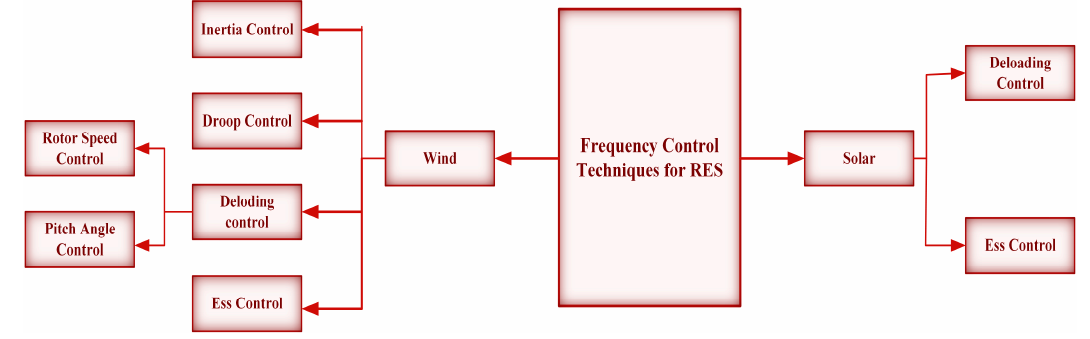
Figure 6. Frequency control techniques for RES.